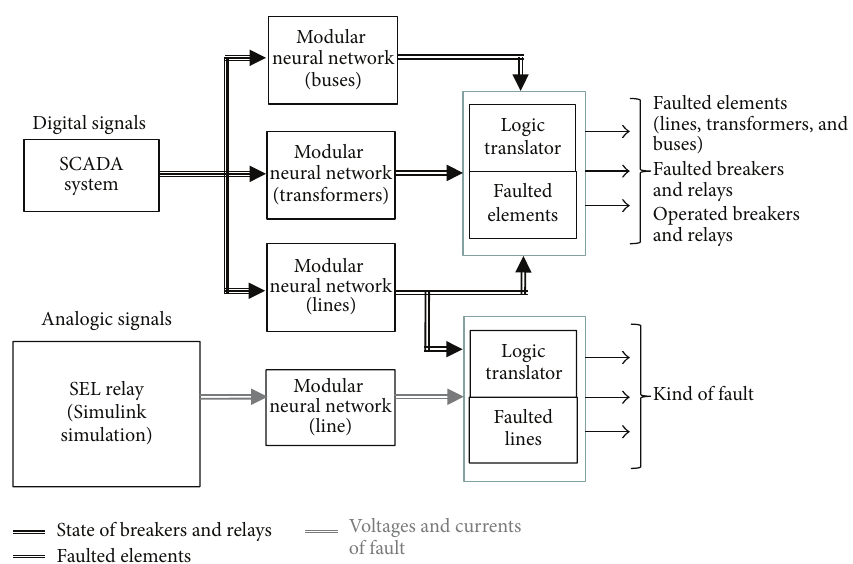
Figure 5: Diagram of the interconnection of the different levels of diagnosis.